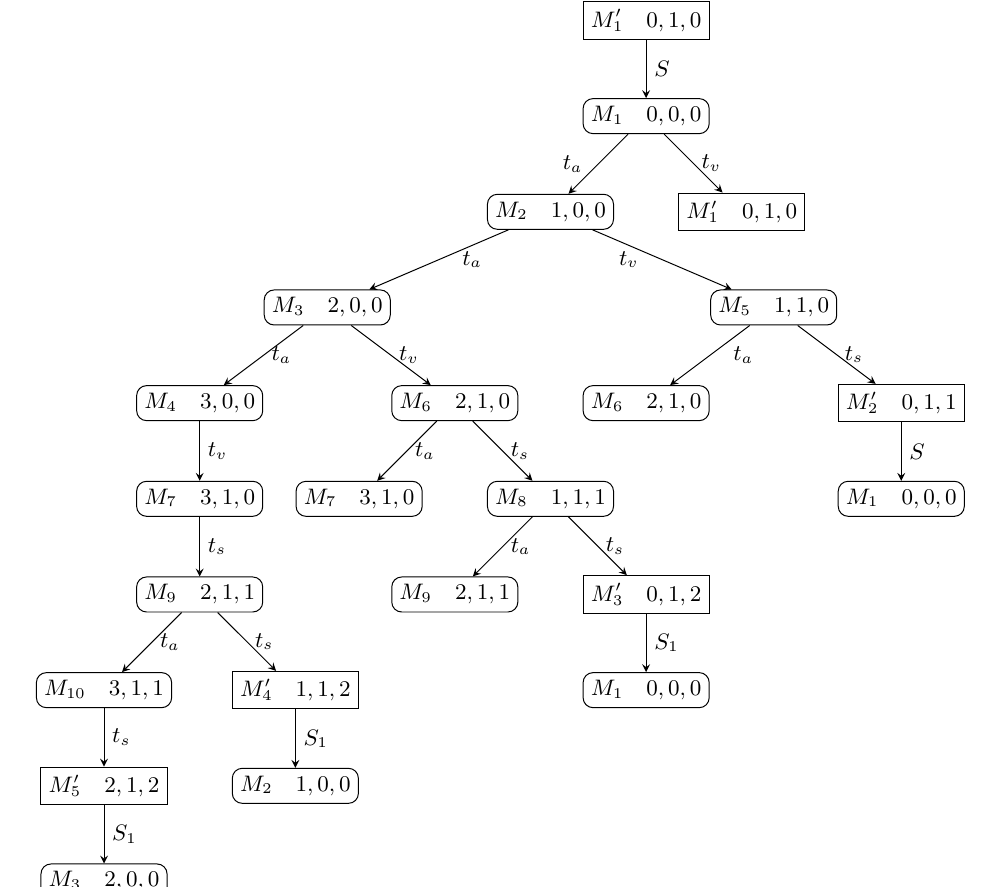
Figure 4: Reachability graph for the MRSPN of Figure 1, with N = 3 , k = 2